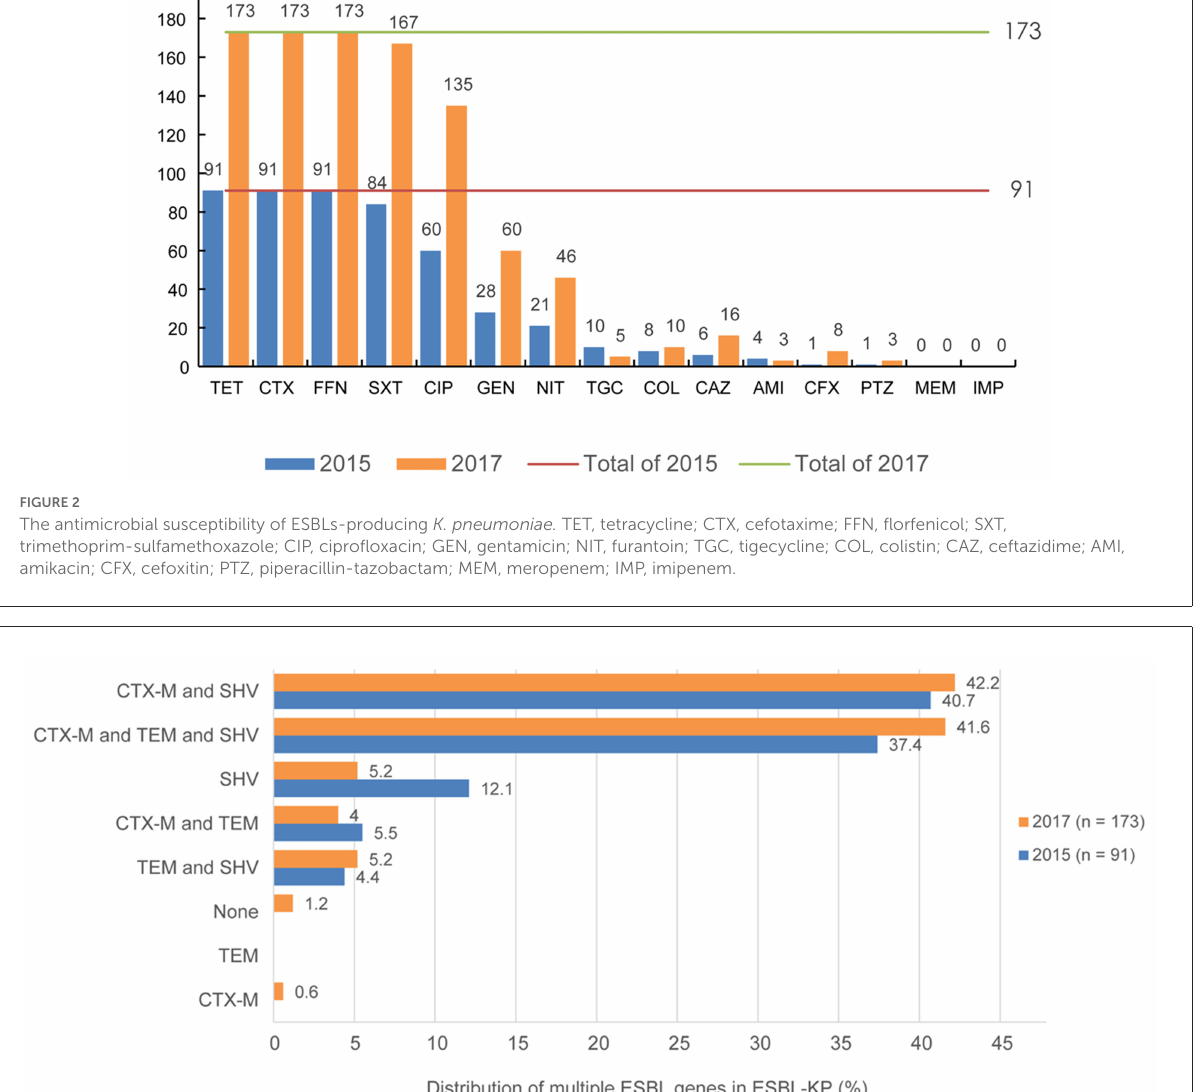
gene mcr-1 gene was detected in one isolate